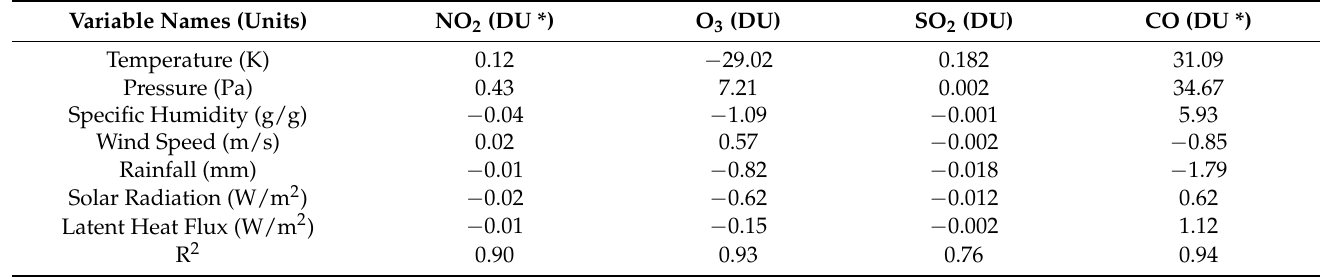
Table 4. Average values of geographically varying coefficients as obtained from GWR modelling over Bangladesh in the period of